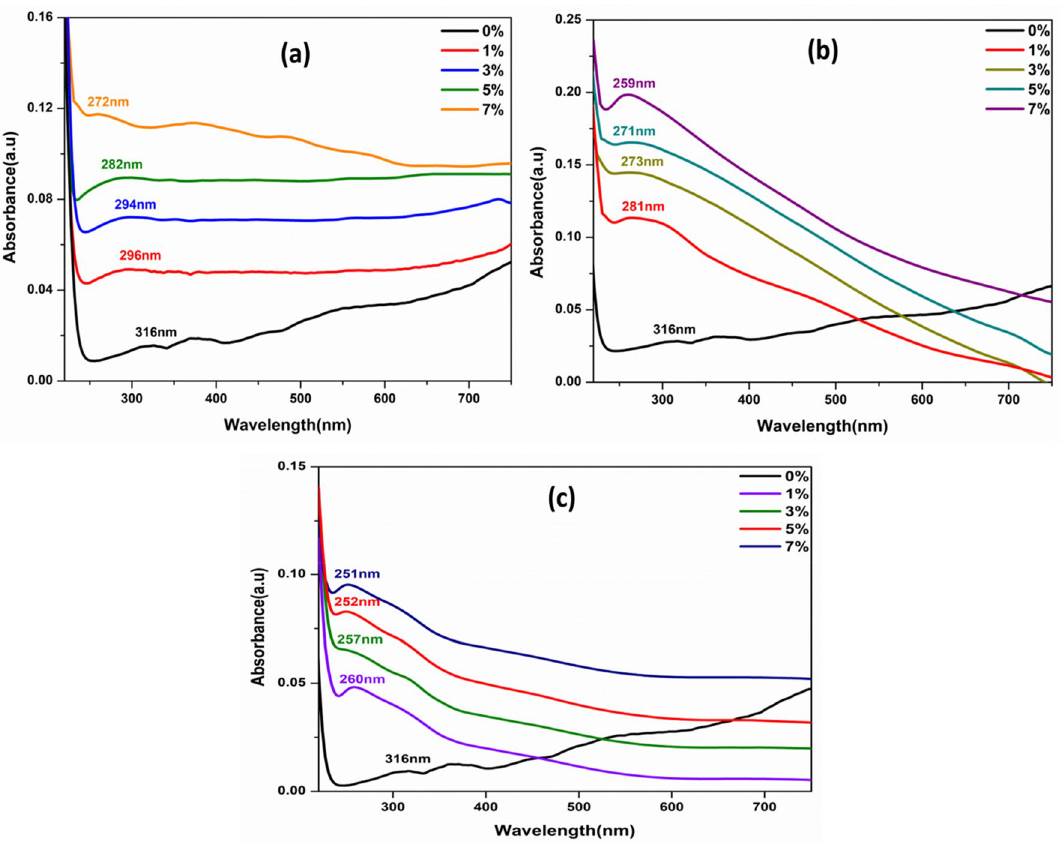
Figure 7. UV–Visible absorption spectra of MgO nanoparticles doped with ( a ) Ni, ( b ) Co and ( c ) Fe at different concentrations (0%, 1%, 3%, 5%, and